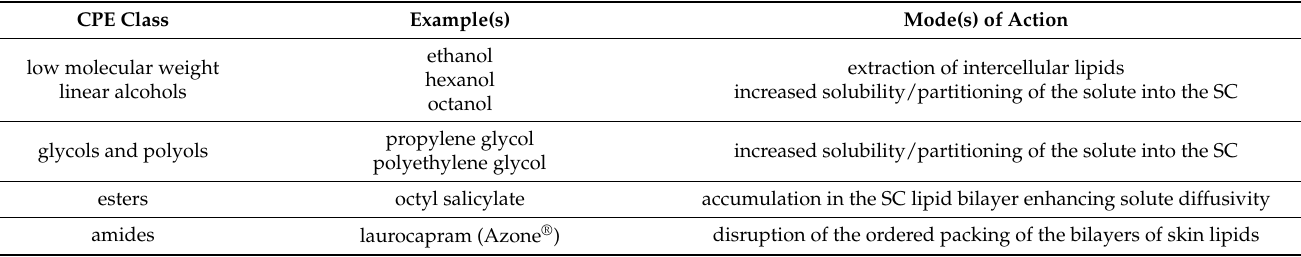
Table 2. Examples of different classes of CPEs and their recognized modes of action [116]. Adapted from the permission of ref. [116]. 2018 Haque and